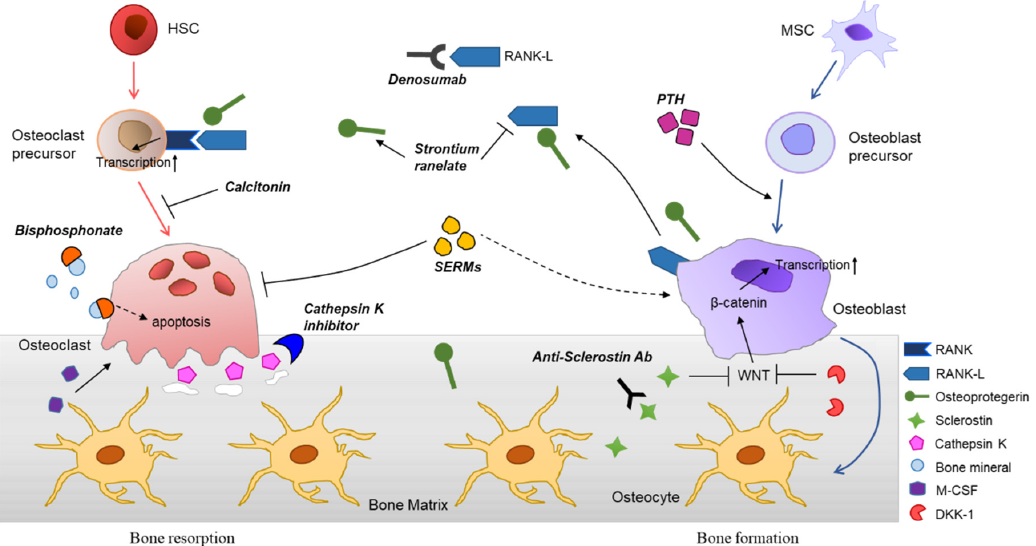
Figure 2. Differentiation of bone cells, bone remodeling process, and various therapeutic agents for osteoporosis. Hematopoietic stem cells (HSCs) are differentiated into osteoclasts, mediated through stimulation of receptor activator of nuclear factor kappaB ligand (RANKL), generated from osteoblasts. Osteoclasts can be further maturated by monocyte-colony stimulating factor (M-CSF). The bone resorption occurs by matrix metalloproteinases and cathepsin K, secreted by mature osteoclasts. Osteoblasts are derived from the mesenchymal stem cells (MSCs) and involved in bone formation. The major roles of osteoblasts in bone remodeling are activation of osteoclasts differentiation and generation of bone cells including osteocytes. Various signaling molecules, such as insulin-like growth factor 1 (IGF-1), transforming growth factor β (TGF- β ), and Wnt induce osteoblast differentiation. Osteocytes are embedded in the bone matrix and orchestrate the bone remodeling. They promote bone formation by releasing osteoprotegerin together with osteoblasts, whereas suppress osteoblastogenesis by secretion of sclerostin and Dickkopf-related protein 1 (DKK- 1), inhibitors of Wnt signaling. Many therapeutic agents are being developed based on the molecular biology of bone and used clinically. Anti-resorptive agents are bisphosphonates (BPs), anti-RANKL antibodies (e.g., denosumab), selective estrogen receptor modulators (SERMs), and calcitonin.